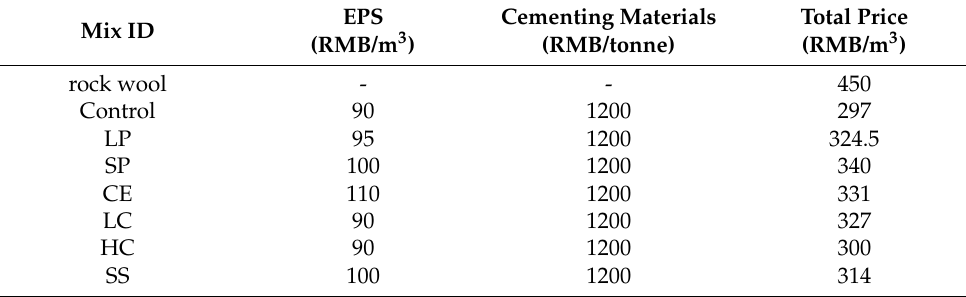
Table 3. The average unit cost of